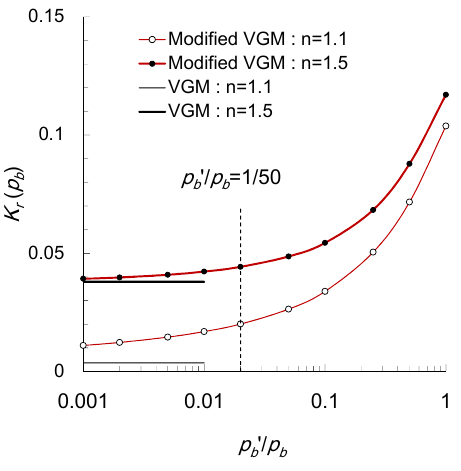
Figure 3. Variation of K r ( p b ) with respect to p b ʹ for two cases of n = 1.1 and 1.5.